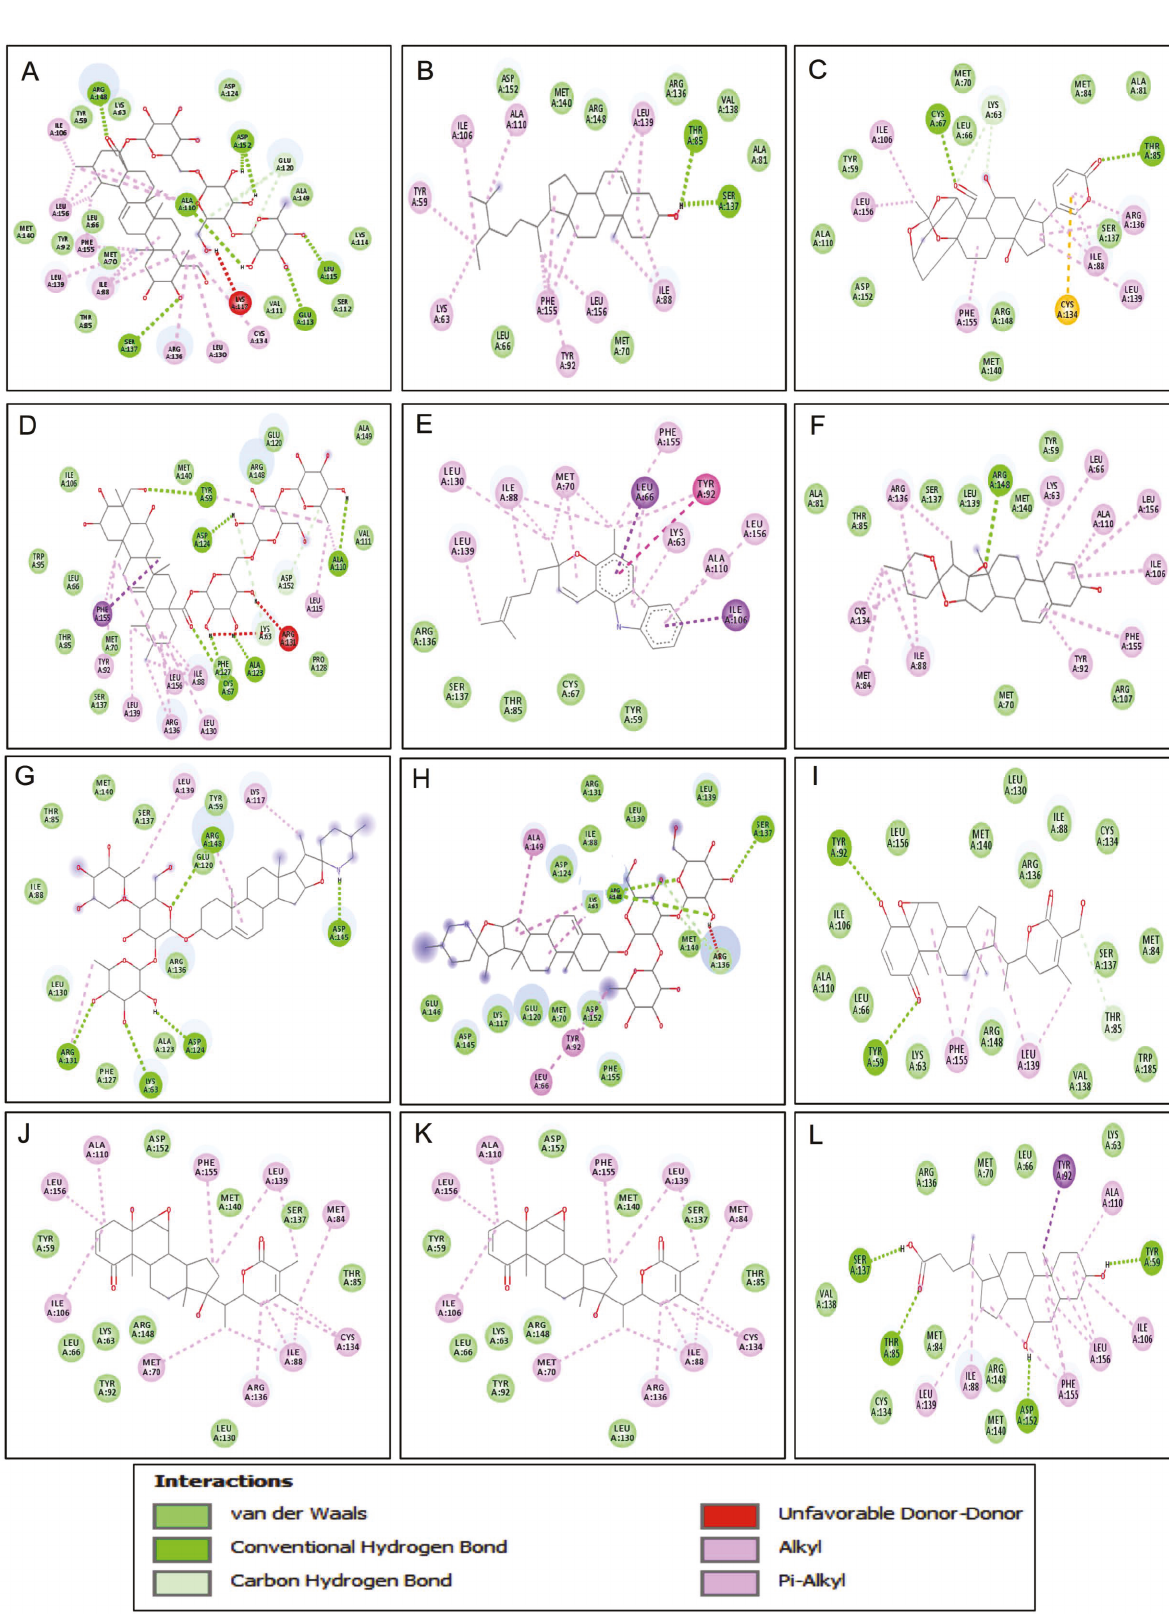
Figure 2. Two-dimensional structure of 11 phytocompounds and bile components in complex with RamR protein of Salmonella Typhimurium: ( A ) asiaticoside, ( B ) beta-sitosterol, ( C ) bryophyllin A, ( D ) madecassoside, ( E ) mahanimbine, ( F ) pennogenin, ( G ) rutin, ( H ) solamargine, ( I ) solasonine, ( J ) withaferin A, ( K ) withanone, and ( L ) chenodeoxycholic